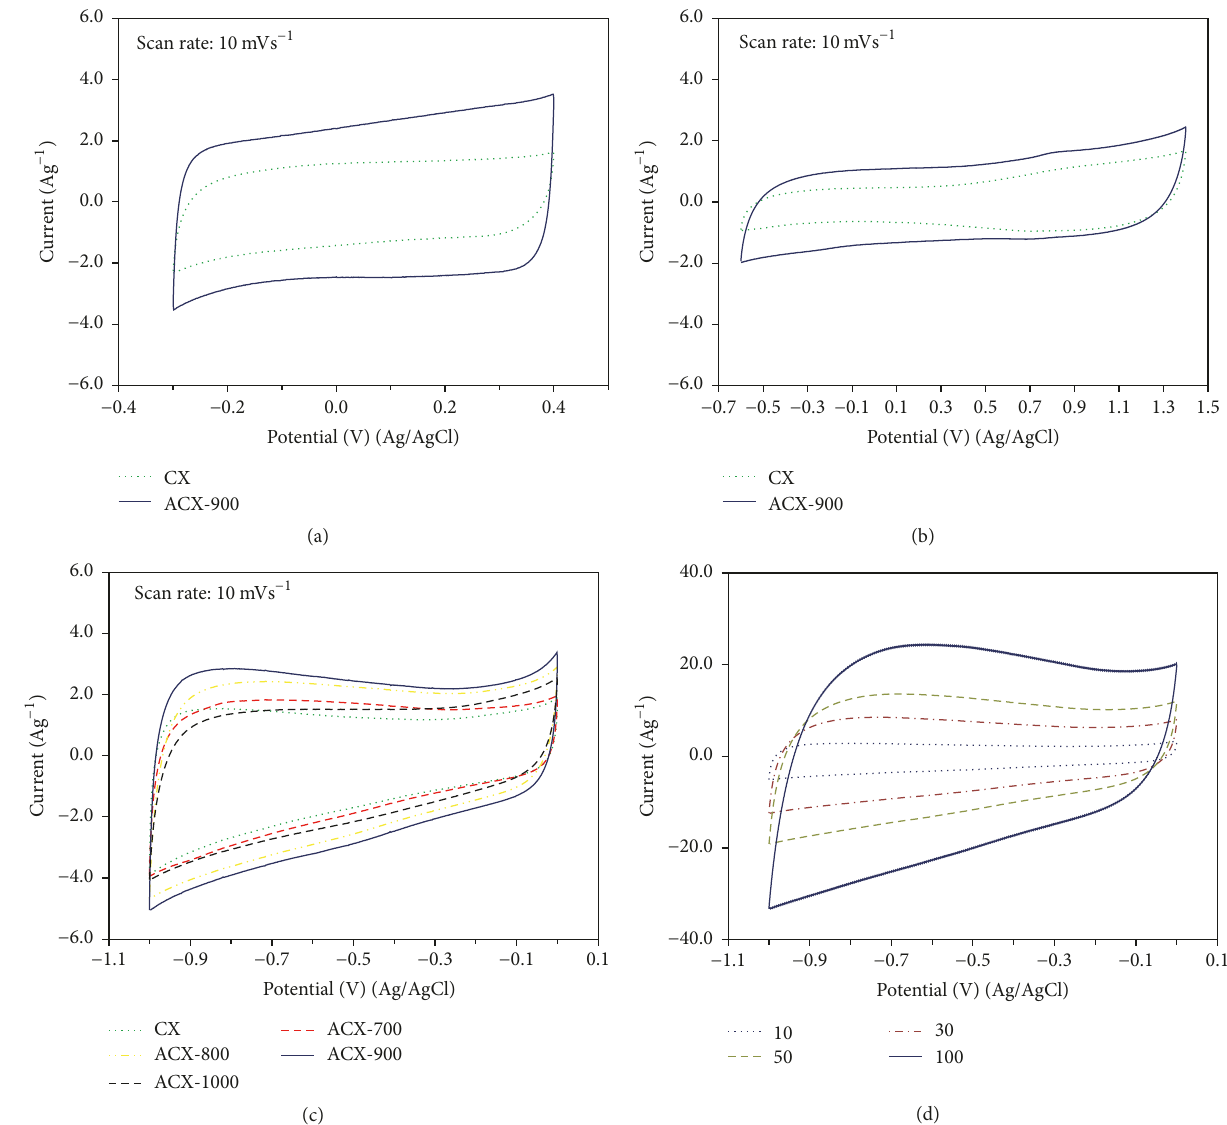
Figure 6: Cyclic voltammograms of CX and ACX electrodes at scan rates of 10mVs −1 (a) in 1M H 2 SO 4 ; (b) in 1M TEABF 4 /ACN; (c) in 6M